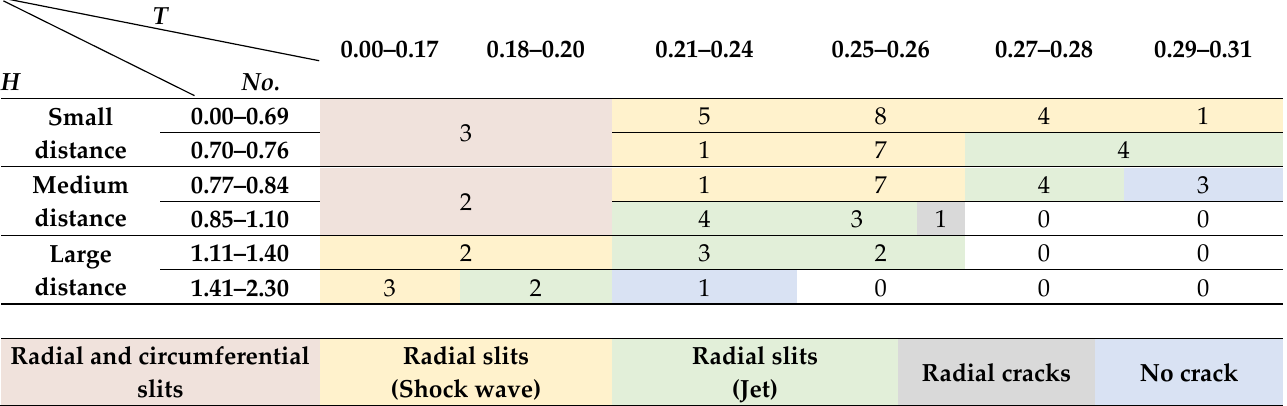
Table 1. Different damage patterns of the ice along with distance parameter H and thickness pa- rameter T .